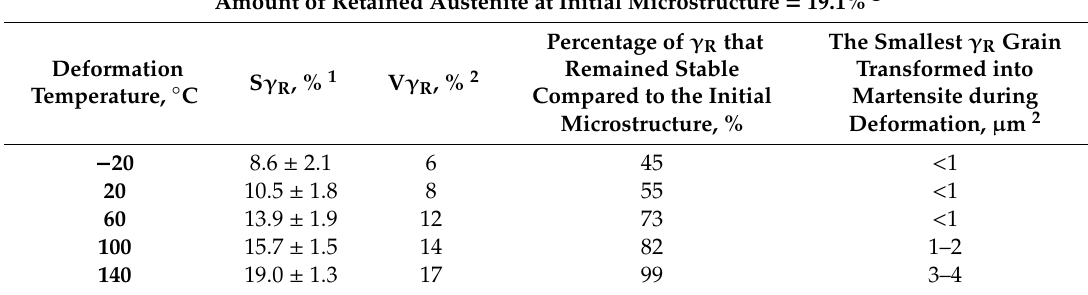
Table 3. Amount of γ R at various deformation